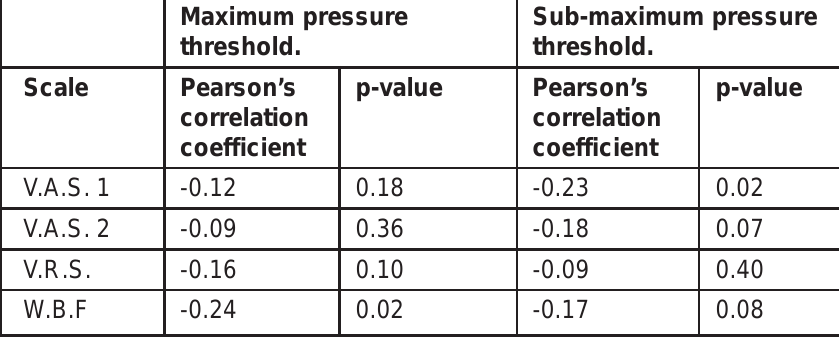
Table 3: P.T.M. readings of the back correlated with the three scales (n= 100).